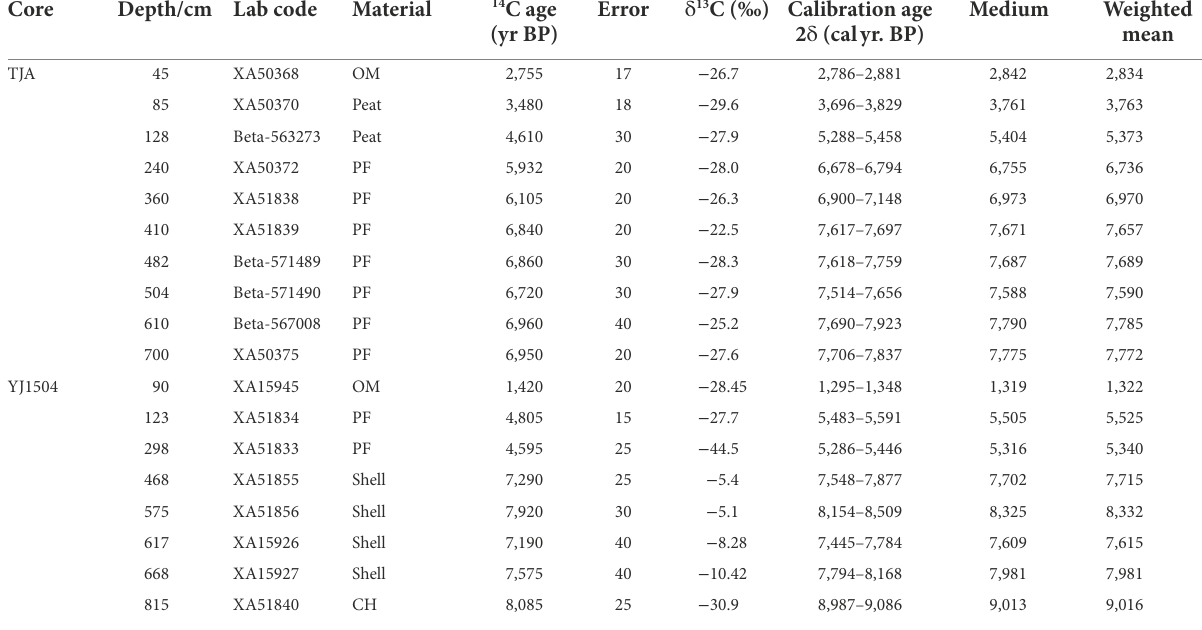
TABLE 1 Detailed information on AMS 14 C datings in cores TJA and YJ1504.